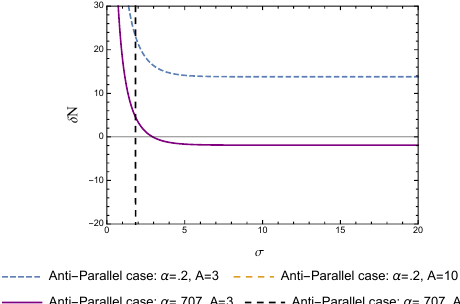
Figure 15 . Anti-parallelly accelerating detectors in (1 + 1) dimensions with thermal background: δ N VS σ = β ∆ E plot for different fixed values of the coefficient α and A with ∆ E B